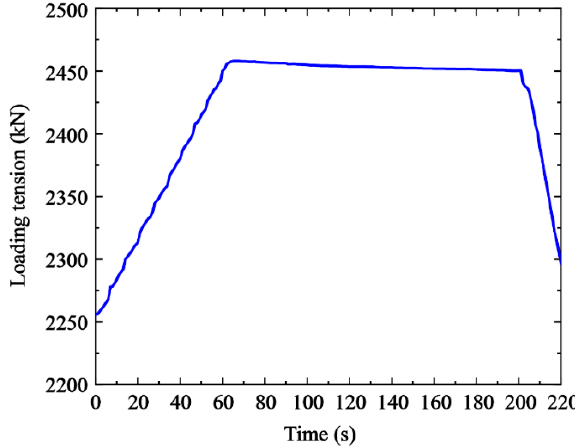
Figure 4. Loading tension measured by the load cell.